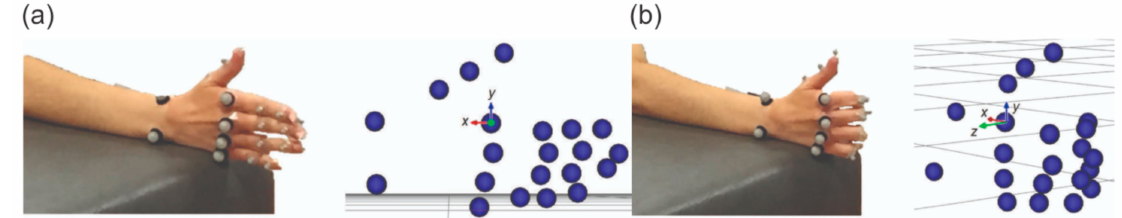
Figure 9. ( a ) Initial position to record. ( b ) Hand in closed fist